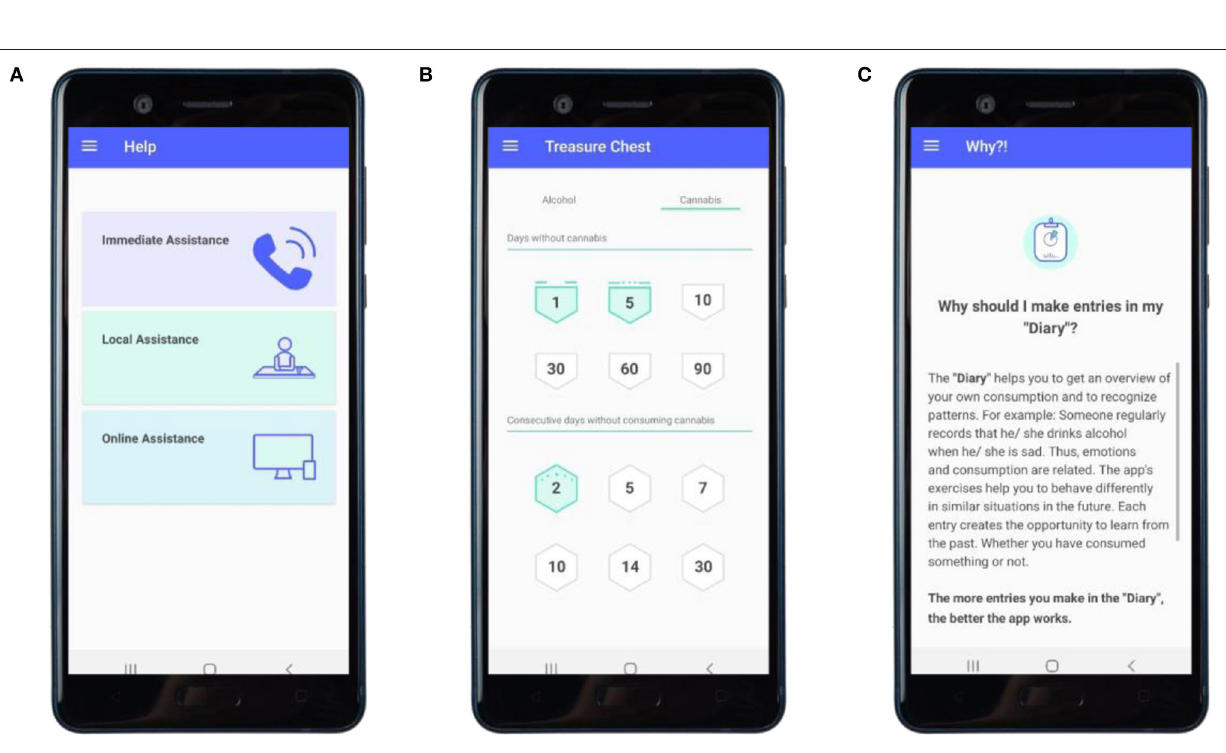
Frontiers in Public Health |